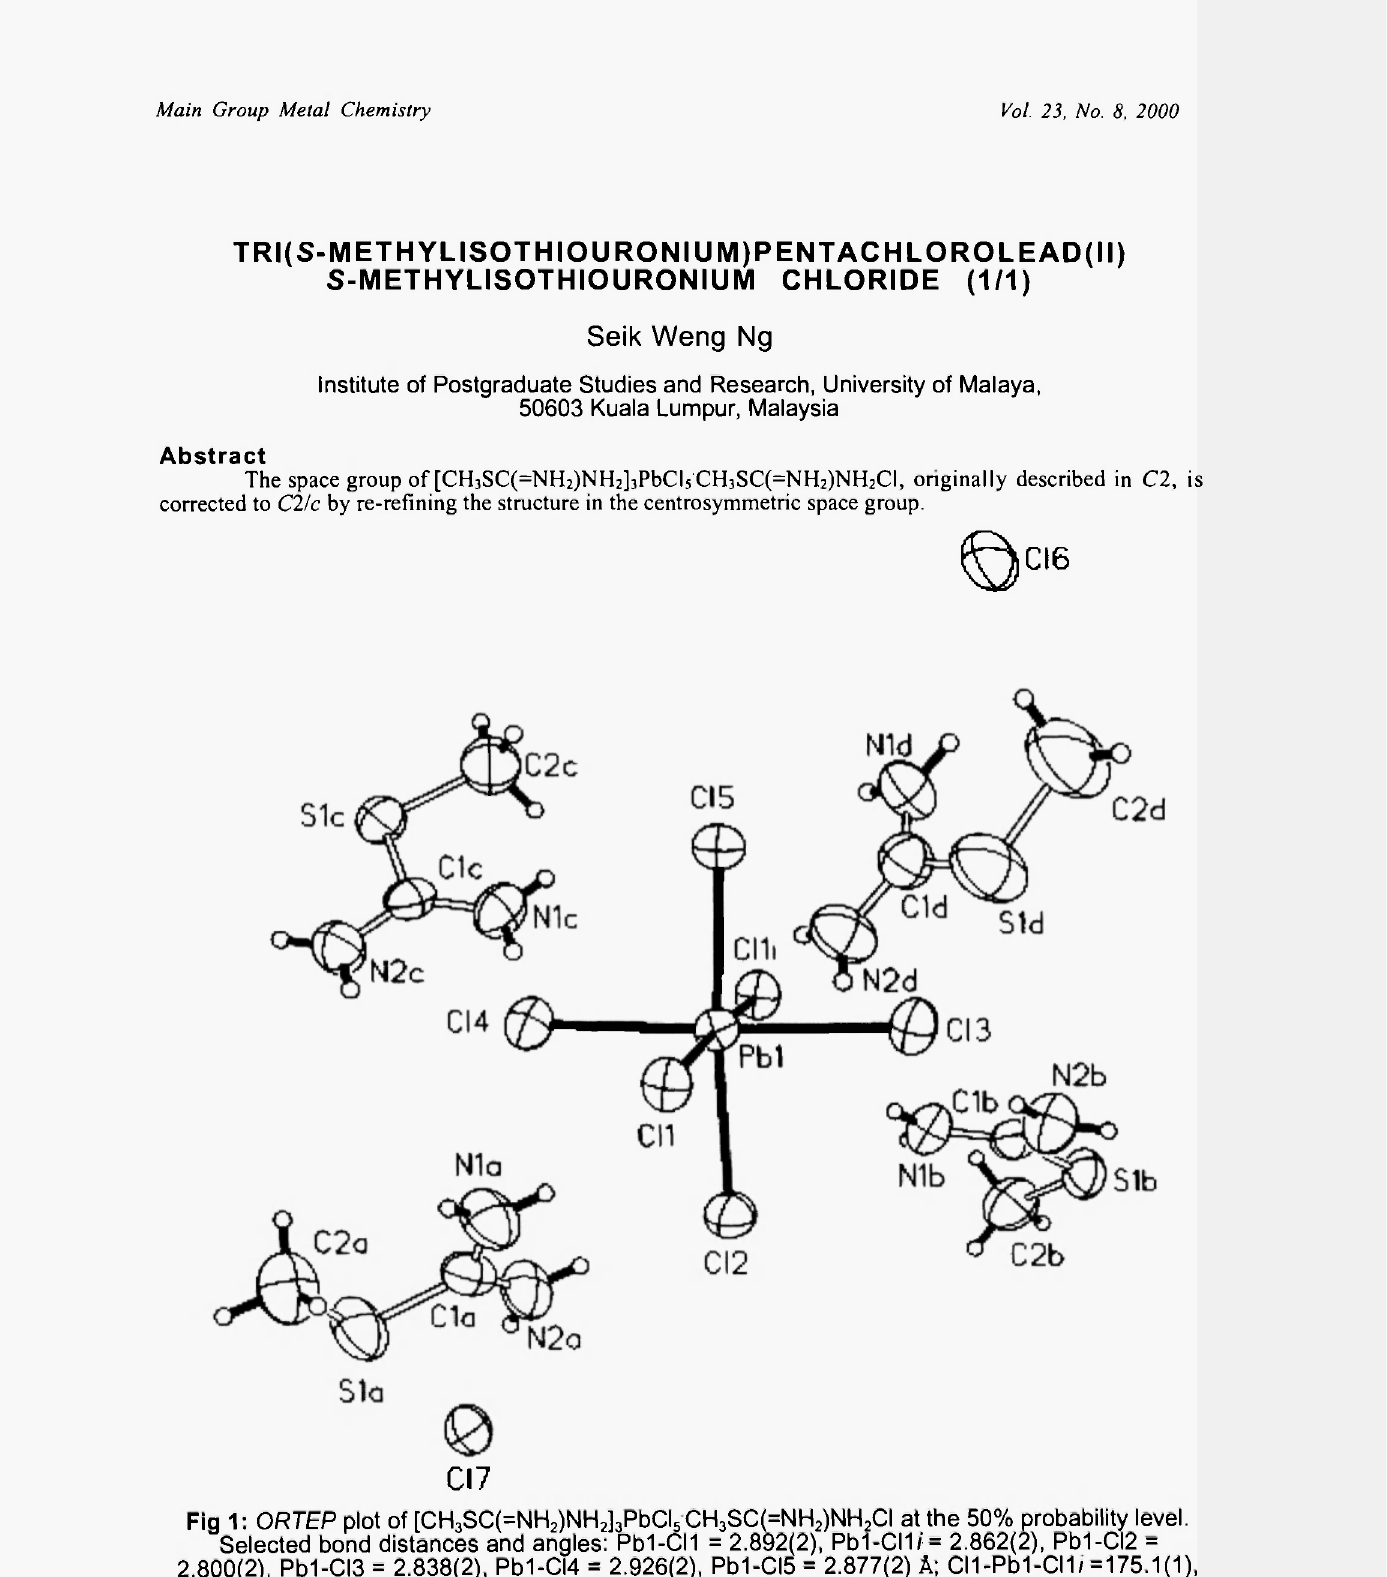
Fig 1: ORTEP plot of [CH 3 SC(=NH 2 )NH 2 ]3PbCI 5 CH 3 SC(=NH 2 )NH 2 CI at the 50% probability level. Selected bond distances and angles: Pb1-CI1 = 2.892(2), Pb1-CI1/= 2.862(2), Pb1-CI2 = 2 800(2), Pb1-CI3 = 2.838(2), Pb1-CI4 = 2.926(2), Pb1-CI5 = 2.877(2) A; CI1-Pb1-CI1/ =175.1(1), CI1-Pb1-CI2 = 83.6(1), CI1-Pb1-CI3 = 96.2(1), CI1-Pb1-CI4 = 94.3(1), CI1-Pb1-CI5 = 83.2(1),